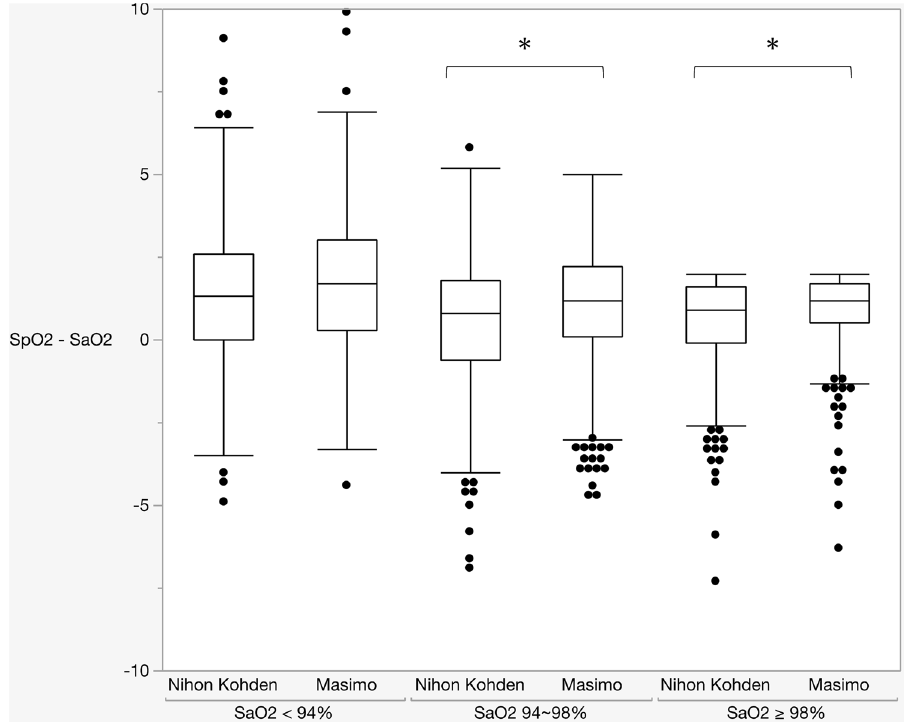
Figure 3. Differences in the pulse oximeters’ SpO 2 measurements among SaO 2 categories. Three SaO 2 categories were established (SaO 2 < 94%, 94% ≤ SaO 2 < 98%, SaO 2 ≥ 98%). The vertical axis represents SpO 2 – SaO 2 , the horizontal axis represents Nihon Kohden SpO 2 and Masimo SpO 2 for each of the three groups. There were significant differences in the groups with SaO 2 ≥ 94%. However, there was no significant difference in the SaO 2 < 94% group. *: P < 0.005.